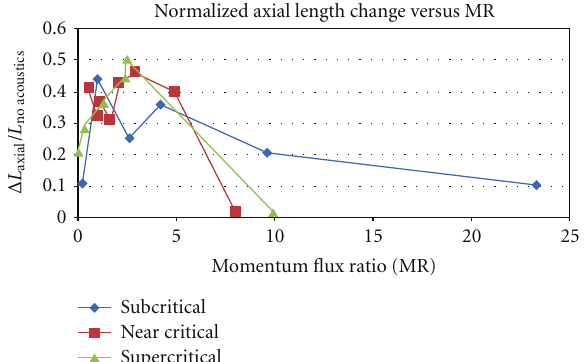
Figure 27: Maximum length change between dark-core length without acoustics and dark-core length with acoustics ( Δ L axial ) divided by the dark-core length without acoustics ( L no acoustics ) for each momentum flux ratio case. Results for a coaxial injector. Rodriguez et al. [54].